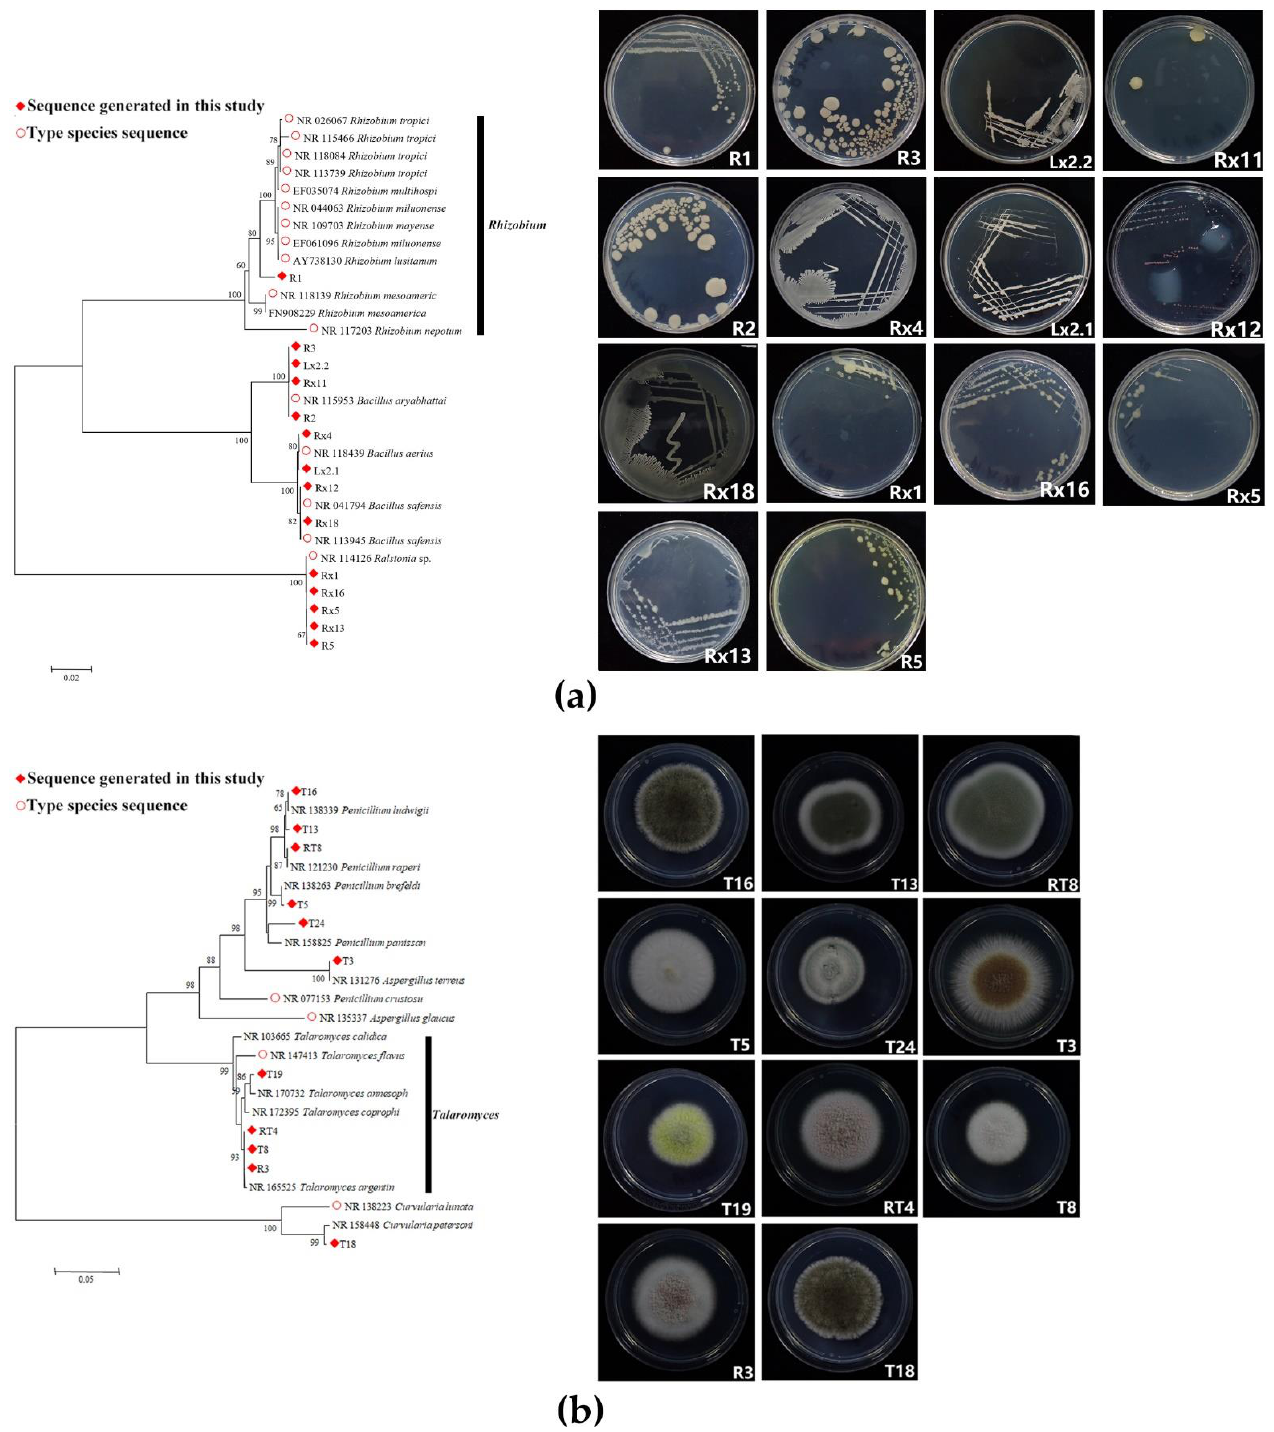
Figure 5. Phylogenetic tree of bacteria ( a ) and fungi ( b ). The similarity distance scale is provided in the lower left corner. Values on the nodes of the phylogenetic tree are bootstrap values.